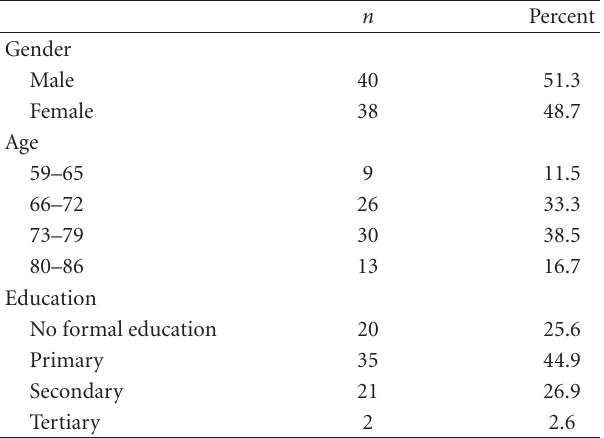
Table 1: Main characteristics of the study sample ( N =